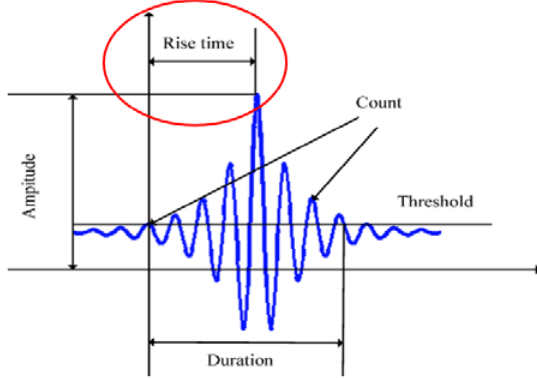
Figure 18. Typical schematic of an AE waveform.